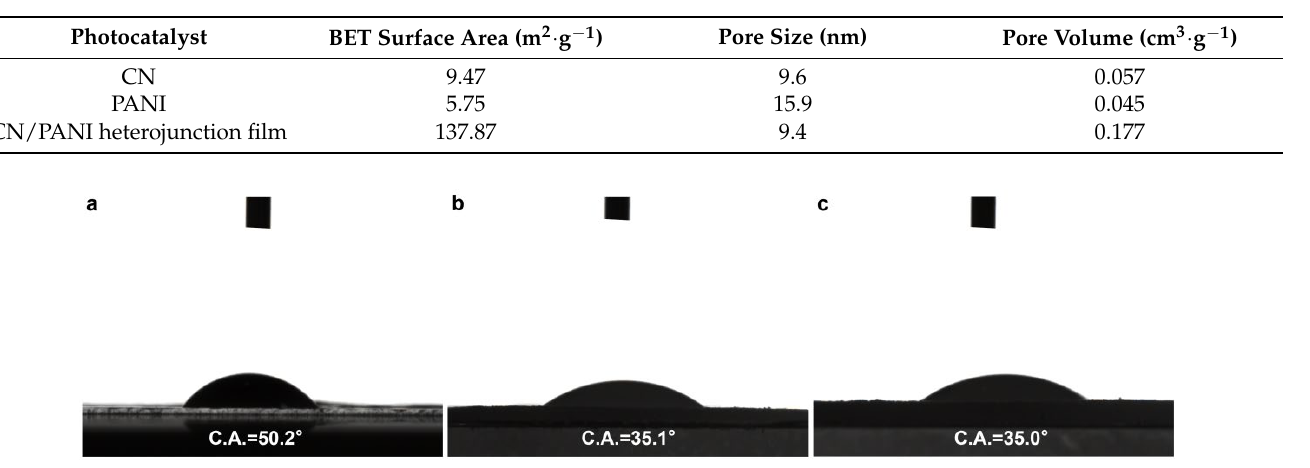
Table 1. BET surface area, pore size, and pore volume of the pristine CN, PANI, and CN/PANI heterojunction film.